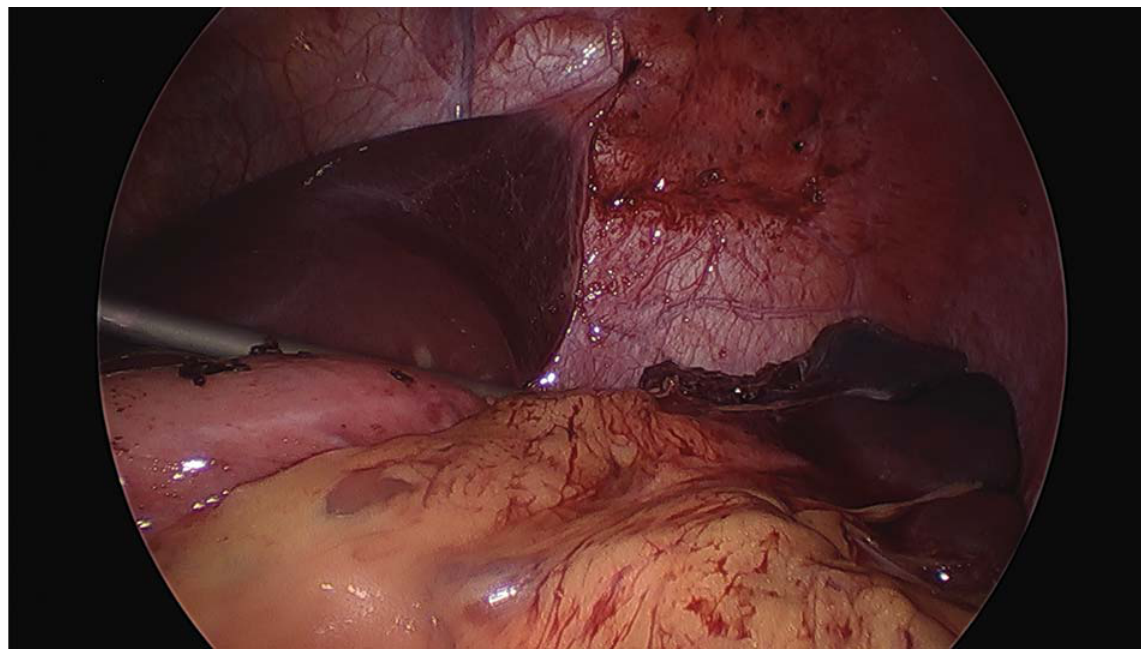
Fig. 6 Intraoperative image. Postoperative